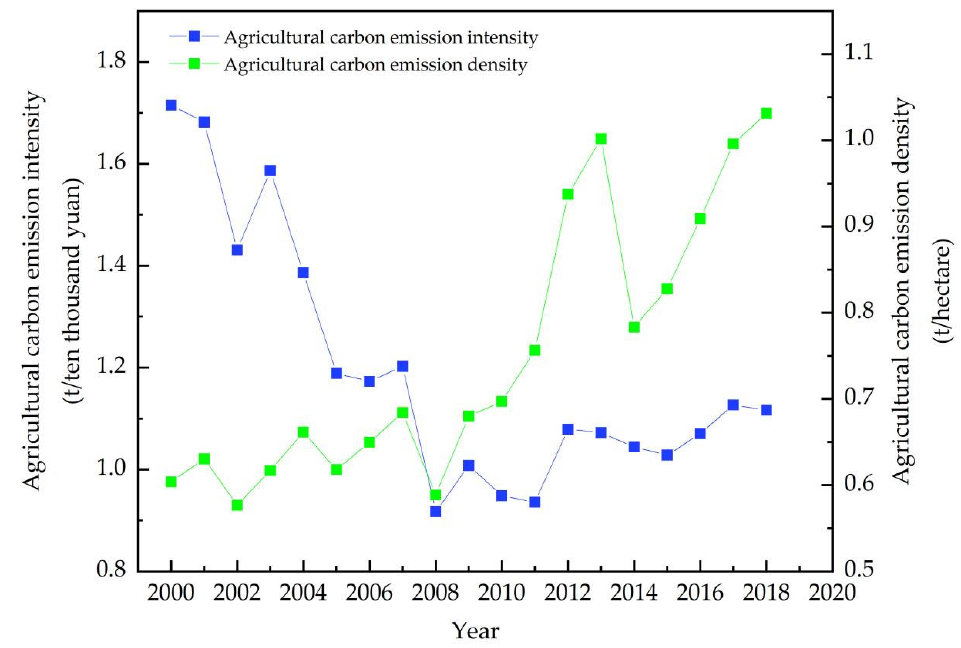
Figure 2. Agricultural carbon emission intensity and density in Heilongjiang province (2000–2018).